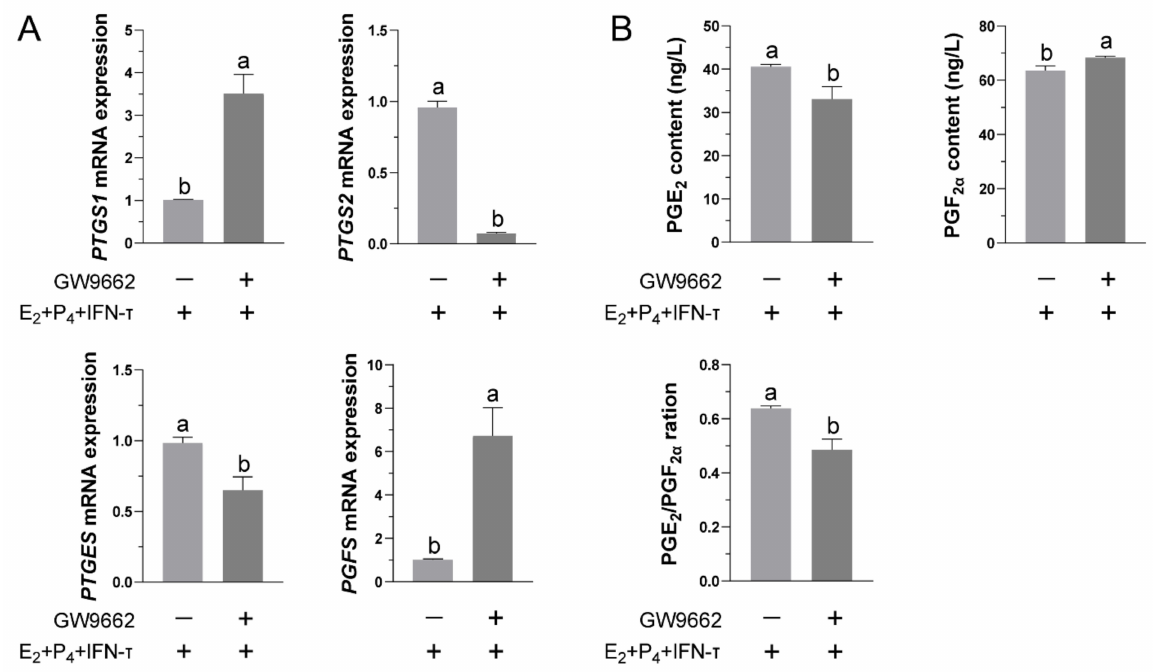
Figure 4. Effects of the inhibition of PPAR γ activity in STCs on the secretion of PGs after hor- mone treatment: ( A ) After inhibiting PPAR γ activity with GW9662, the relative mRNA levels of prostaglandin synthases in STCs were measured by real-time quantitative PCR. The β -actin gene was used as a control gene. ( B ) The concentrations of PGE 2 and PGF 2 α were determined by ELISA after inhibiting PPAR γ activity, and the ratio of PGE 2 /PGF 2 α was calculated. Data are shown as the mean ± standard deviation (SD) of three independent trials. Different letters above the bars indicate significant differences ( p <